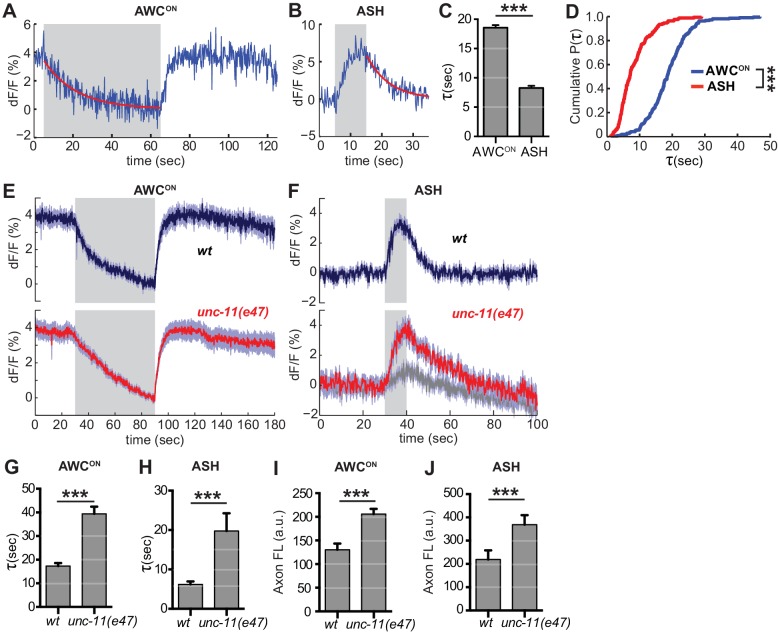
Synaptic vesicle retrieval is accelerated by AP180/CALM.(A,B) Representative single exponential fits (red) to single trials of (A) AWCON and (B) ASH VGLUT-pH decays upon stimulus addition or removal, respectively. For each neuron, some responses were consistent with double exponential decay models (Figure 6—figure supplement 1). (C) Average time constant of AWCON and ASH decays from single exponential fits. AWCONn = 218 (76 animals, 2–3 trials each). ASH n = 168 (56 animals, 2–3 trials each). ***p<0.0001, unpaired t-test. (D) Empirical cumulative distribution plot of data in (C). Distributions differ by Kolmogorov-Smirnov test, ***p<0.0001. (E,F) Average VGLUT-pH responses in unc-11(e47) mutants. (E) AWCON responses in unc-11(e47) n = 27 (10 animals, 2–3 trials each), wt n = 15 (5 animals, three trials each). One unc-11(e47) animal did not respond and was removed from the analysis. (F) ASH responses in unc-11(e47) mutants. wt n = 21 (7 animals, three trials each). unc-11(e47) n = 23 (8 animals, 2–3 trials each). Red trace: mean of 9 trials (five animals, 1–2 trails each) with clear responses to odor addition. Magnitude of response does not differ from wt (p=0.72, peak odor response); Gray trace: mean of 14 trials that produced weak or non-detectable responses to odor addition, significantly different from wt (p<0.0001, peak odor response). One-way ANOVA, Tukey’s correction. (G,H) Average time constants from single exponential fits (initial 20 s of decay) of data in (E,F). For ASH unc-11(e47) mutants, only data from the red trace was used. Unpaired t-test, p<0.0001. AWCON
unc-11(e47) n = 25 (10 animals, 2–3 trials each); wt n = 15 (5 animals, three trials each). ASH n as in (F). (I,J) Average axon fluorescence (first 5 frames of the recording). (I) AWCON
wt n = 12 animals, unc-11(e47) n = 19 animals. (J) ASH wt n = 7 animals, unc-11(e47) n = 8 animals. Unpaired t-test, p<0.0001. Gray areas mark stimulus periods. Shading and error bars indicate S.E.M.10.7554/eLife.31234.018Figure 6—source data 1.Source data for Figure 6.